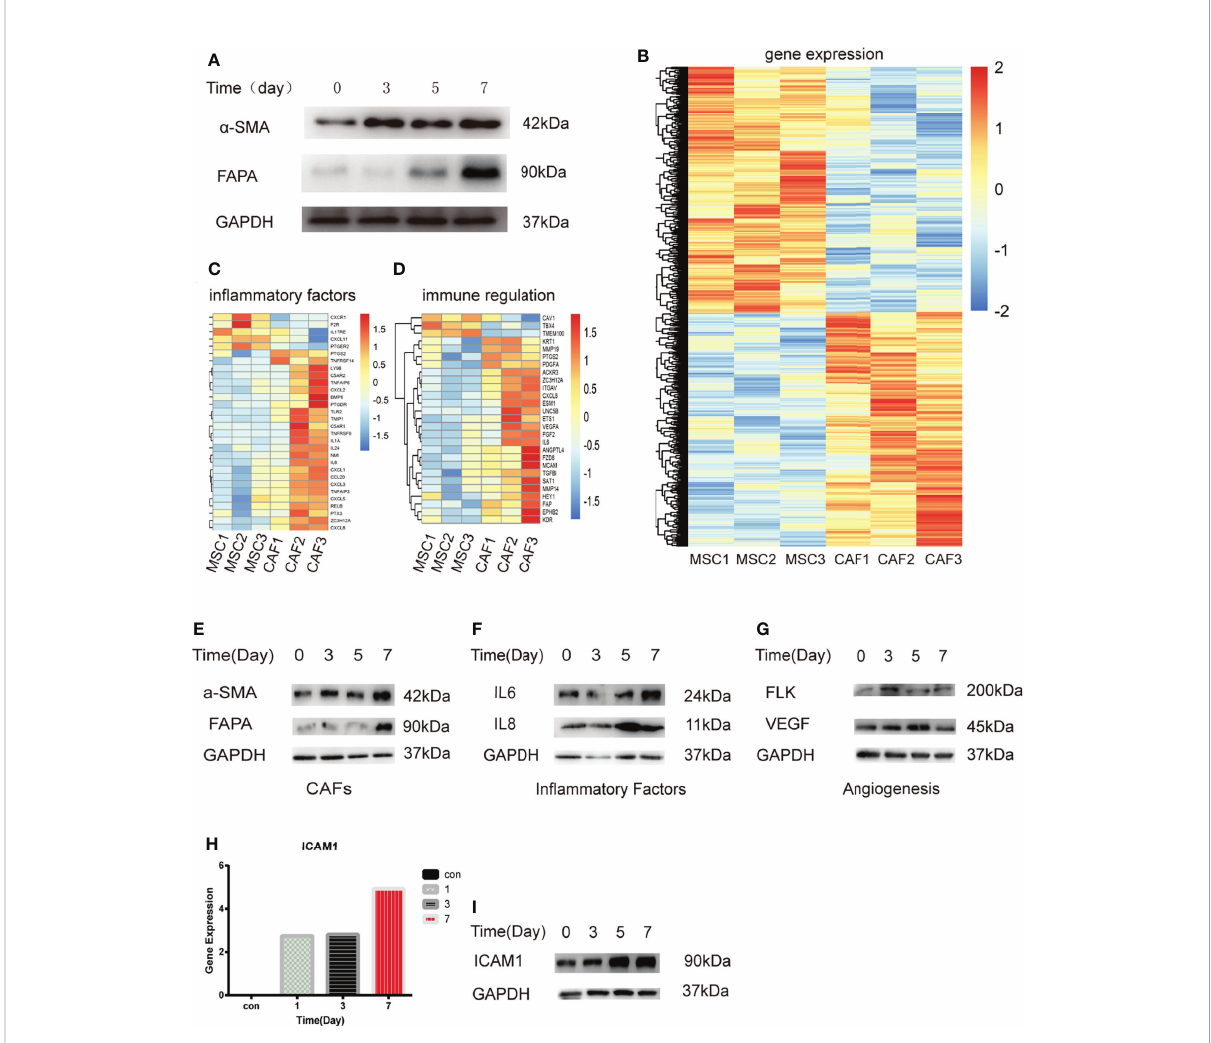
FIGURE 1 Transcriptome analysis of MSCs treated with H-Exos. (A) Detection of genes associated with MTCAF using Western blotting with the situation of MSCs with H-Exos at days 0, 3, 5, and 7. (B) Heat map showing the differentially expressed genes (DEGs) in HCT116-exos – treated MSCs (CAF1- 3) and control MSCs (MSC1-3). (C) DEGs associated with in fl ammatory factors. (D) DEGs associated with immune regulation. (E) Detection of genes associated with MTCAF using Western blotting with the situation of co-culturing with HCT116 cells and MSCs at days 0, 3, 5, and 7. (F) Detection of genes associated with in fl ammatory factors using Western blotting. (G) Detection of genes associated with angiogenesis using Western blotting. (H) The expression of ICAM-1 was measured at days 0, 1, 3, and 7 by expression pro fi ling gene chip (I) The expression of ICAM-1 using Western blotting at days 0, 1, 3, and